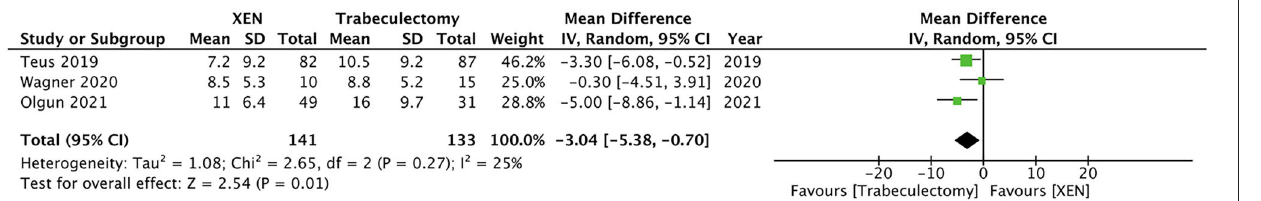
Frontiers in Medicine |